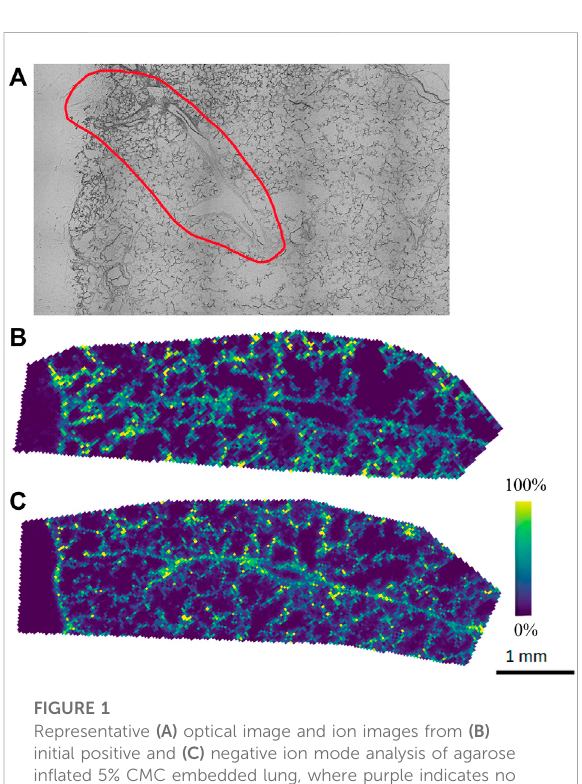
FIGURE 1 Representative (A) optical image and ion images from (B) initial positive and (C) negative ion mode analysis of agarose in fl ated 5% CMC embedded lung, where purple indicates no presence ofthespecies andyellow indicateshigh abundance of the